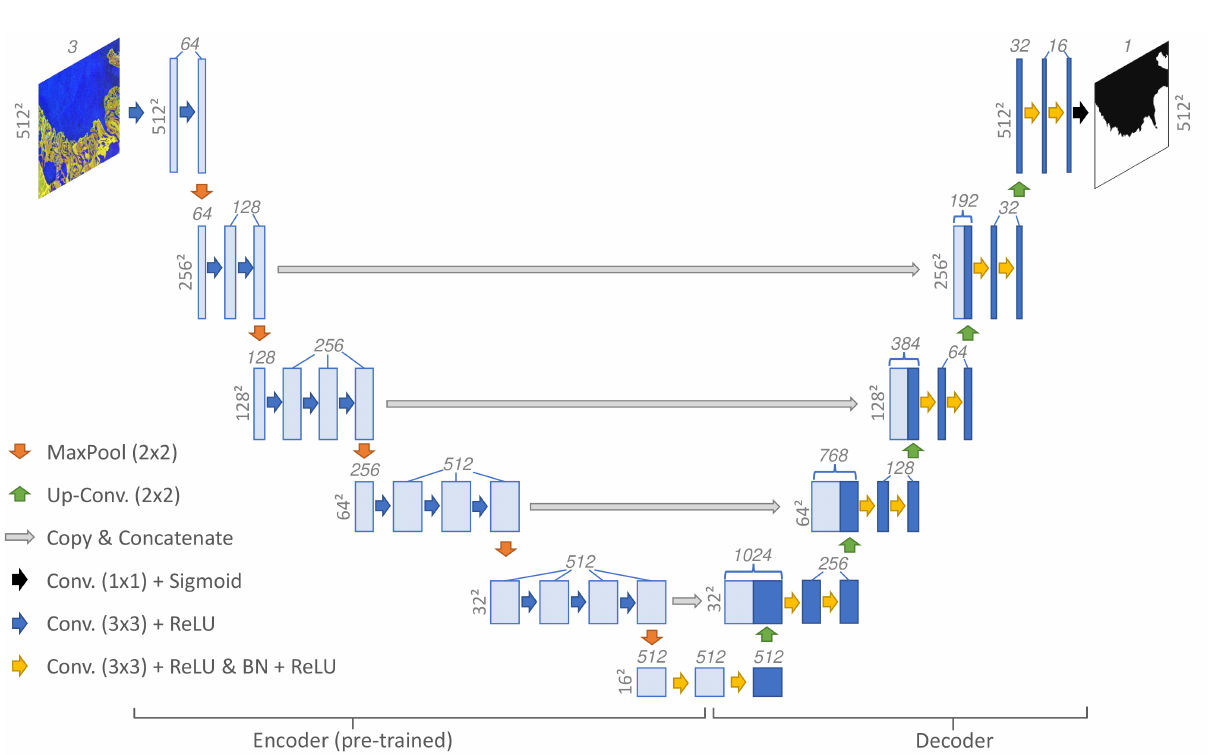
Figure 5. Schematic visualization of a VGG16 U-Net architecture. The vertical numbers at the side of each feature block represent the x–y-dimensions. The numbers in italics above each block represent the amount of feature maps (layers). Feature maps inside the down-sampling path of the (pre-trained) encoder are displayed in light blue color, whereas feature maps within the up-sampling path of the decoder are visualized in dark blue. The following abbreviations are used: Convolution (Conv), Batch Normalization (BN), and Rectified Linear Unit